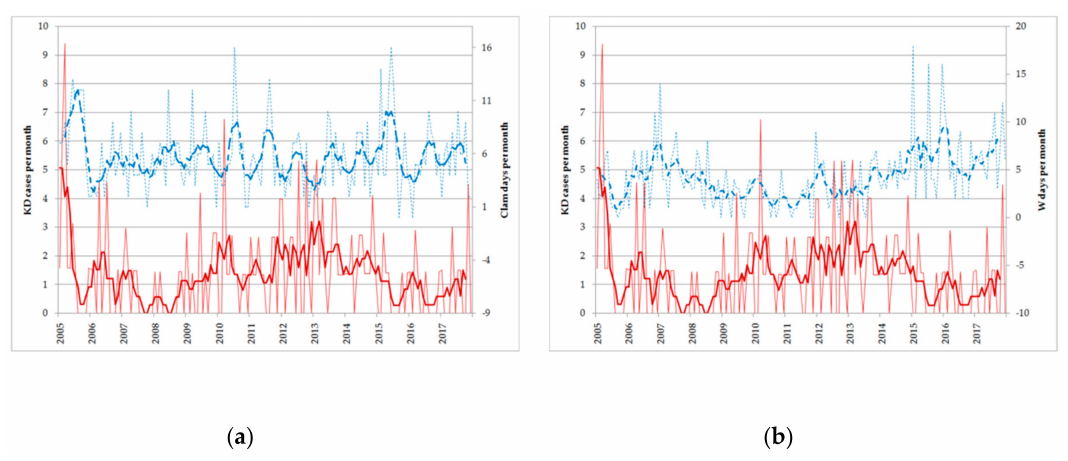
Figure 6. ( a ) Number of KD onset per month in Romagna as a function of time (red thin line, left axis) and its 5 five month running mean (thick red line, left axis) and number of calm days per month in Romagna (thin dashed blue line, right axis) together with its five month running mean (thick dashed blue line). ( b ) Same as panel a, but blue lines refer to W wind days per month in Romagna. Table 5. Correlation values between the monthly and annual time series of the number of KD onsets and PM10 mean concentrations ( µ g) in rural (R) and urban (U) stations located in the plains in Emilia (a) and in Romagna. PM10 R PM10 U